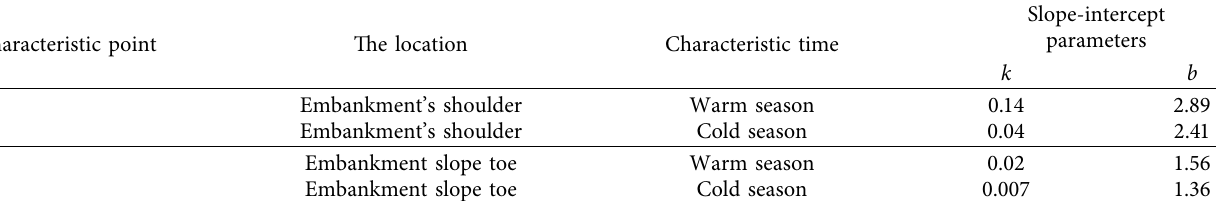
Table 3: Te value of slope and intercept parameter.